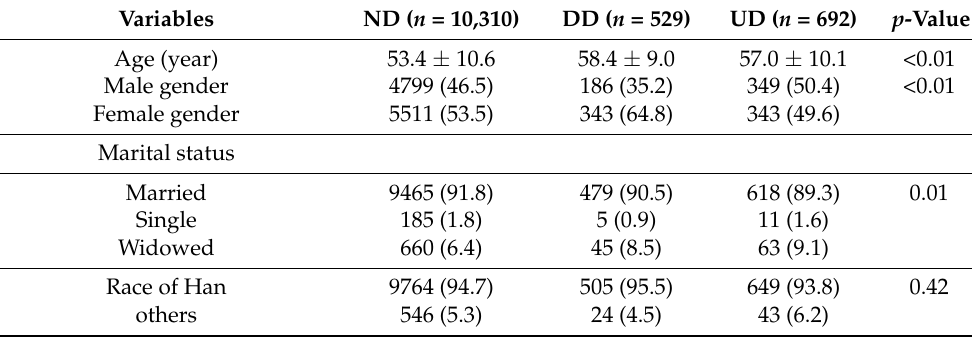
Table 1. Baseline characteristics of study population ( n =